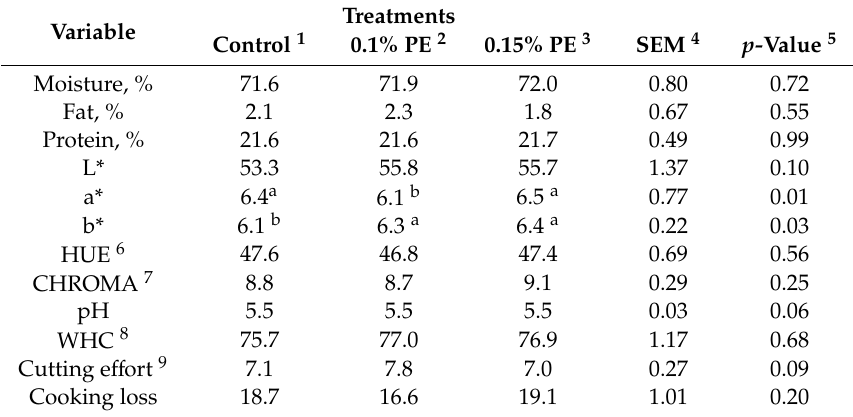
Table 6. Meat quality (chemical composition and physical analysis) of pigs supplemented with plant extracts (PE) during development and growing-finishing